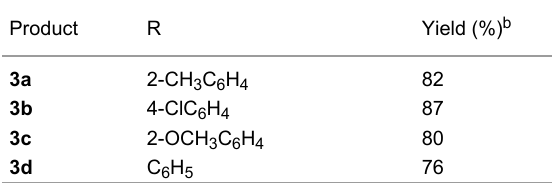
Table 4: Synthesis of 7-hydroxy-2,3-dihydro-2-thioxo-1,3-diarylquina- zolin-4(1 H )-ones a